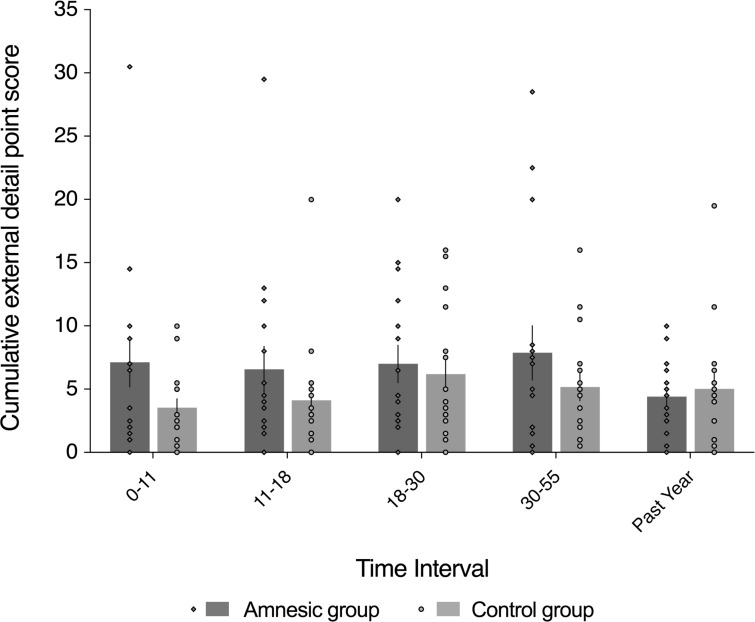
External (non-episodic, mainly personal semantic) detail was intact for recent and remote memories (~1–60 year interval).The plot depicts mean cumulative (summed across the general and specific probes) number of external details generated on the AI across the five sampled intervals, as a function of group (amnesic group, N = 16; control group, N = 16). With the exception of the past year, each time interval refers to age of the participants at the time of the remembered event; for example, 18–30 years refers to an event that occurred when each participant was between 18 and 30 years-of-age. The specificity of the deficit in internal (episodic) detail was revealed by the absence of a significant between-group difference in the amount of external (semantic) detail remembered over the five internals (F(1,30) = 1.24, p=0.275, η2p = 0.040), and the interaction between group and time was not significant (F(4,120) = 1.46, p=0.218, η2p = 0.046). Evidence for a null group difference in external detail aligns with the more general preservation of associative semantic memory (Camel and Cactus Test) (mean z-score = 0.20, s.e.m. = 0.30, t(14) = 0.67, p=0.514, two-tailed one-sample t-test) (Bozeat et al., 2000). Error bars correspond to the s.e.m.